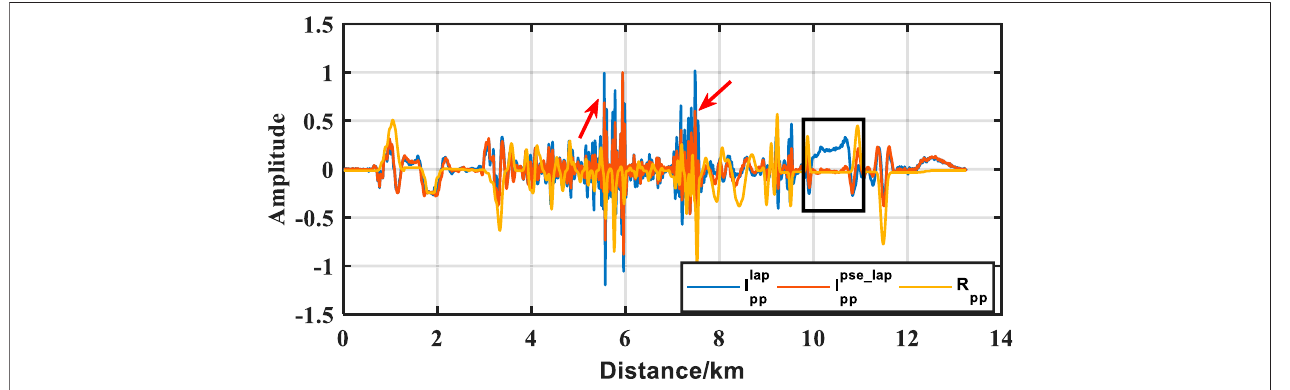
FIGURE 16 | The comparison between normalized amplitudes of theoretical re fl ection coef fi cient R pp (yellow curves) calculated by Zoeppritz equation and traces extracted from Figure 15A (blue curve) and Figure 15B (red curve) at a depth of 1.32 km. The variation trends of traces are consistent with the theoretical re fl ection coef fi cient, and the amplitude of trace from I pse lap pp (red curve) is generally slightly larger than that from I lap pp (blue curve). However, the amplitude of trace from I pse lap pp (red curve) is smaller than that from I lap pp (blue curve) in the fault area (marked by the red arrow). Moreover, the phase of I lap pp (blue curve) is opposite to that of I pse lap pp (red curve) and theoretical solution (yellow curve) at the cover of anticline where sub-cover oil and gas reservoirs develop, marked by a black rectangular box.